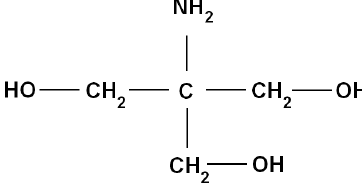
Fig. 2. Structure of Tris. Table 1. Statistical analysis of actual concentrations of TCP and Tris in 72 TCP – Tris – HCl mixture samples.